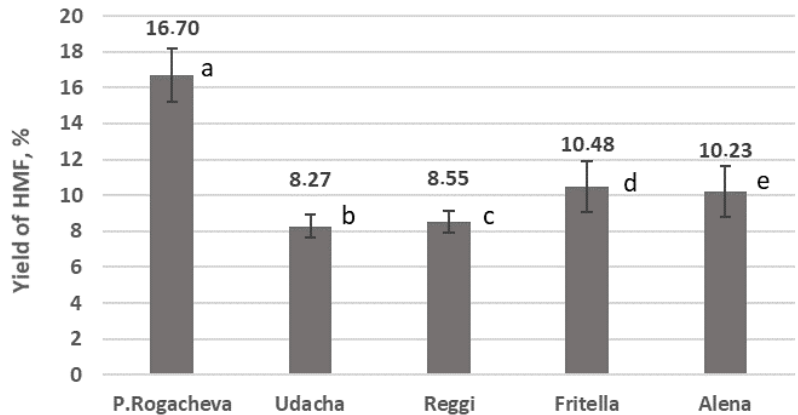
Figure 3. Preparative yields for HMF synthesis from starch from various potato varieties. ANOVA: α = 0.05, F = 22.69, F critical = 3.48, p = 5.29 × 10 −5 . Least significant difference (LSD) = 2.23. Mean difference > LSD for a:b, a:c, a:d, a:e, b:d, c:d.